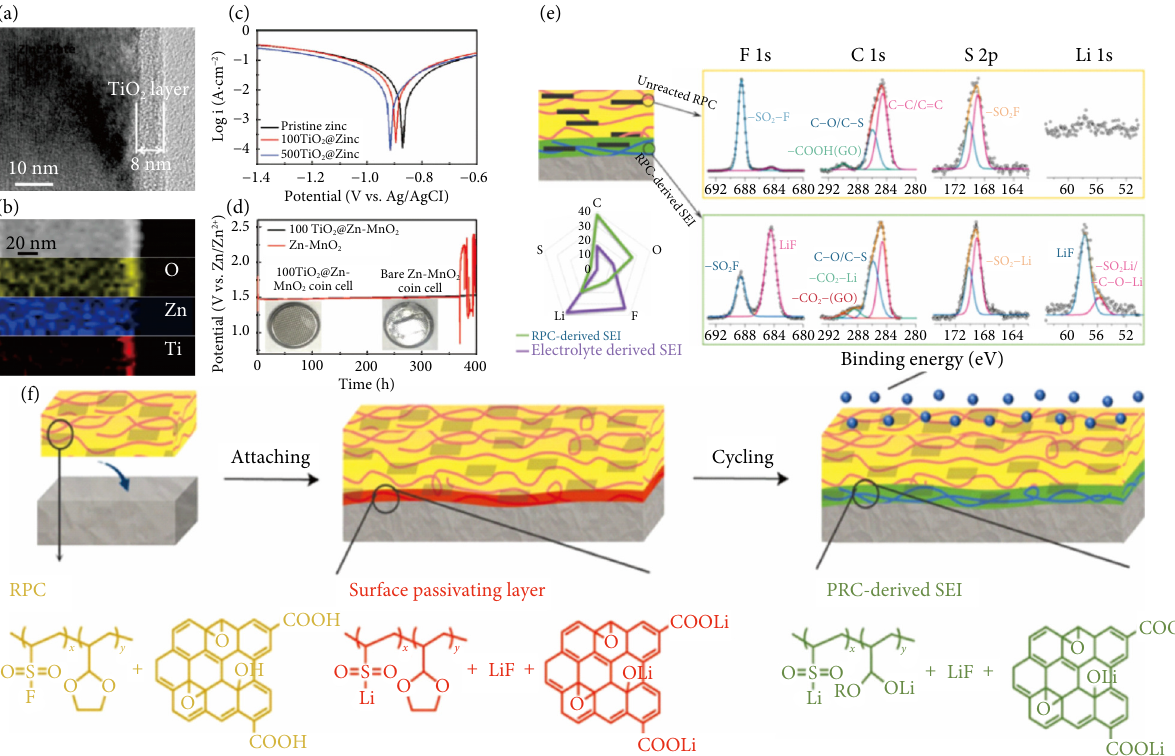
Fig. 6 (a,b) SEM and the mapping images of the inorganic TiO 2 interface layer. (c) Corrosion curves of mental-based Zn anode improved by inorganic TiO 2 interface layer. (d) Self-discharge curves of full cells with and without inorganic interface layer ALD method. (a–d) Reprinted with permission from ref. [74], © 2018 Wiley- VCH Verlag GmbH&Co. KGaA,Weinh. (e) The reaction sequence and SEI structure after cycling, (f) schematic illustration of RPC structure. (e,f) Reprinted with per- mission from ref. [76], © The Author(s), under exclusive licence to Springer Nature Limited 2019. Table 2 Recent advances adopting artificial SEI films for electrode interface optimization